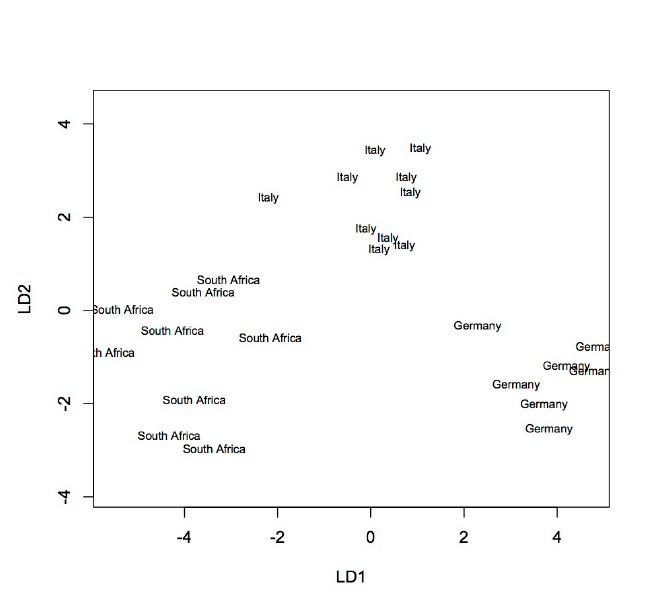
Figure 1 – Standard representation of Wines data through Fisher’s Linear Discriminant Analysis. Scatterplot of the (cid:12)rst two linear discriminant (LD) functions, showing that Weisser Riesling wines from three countries are well separated.